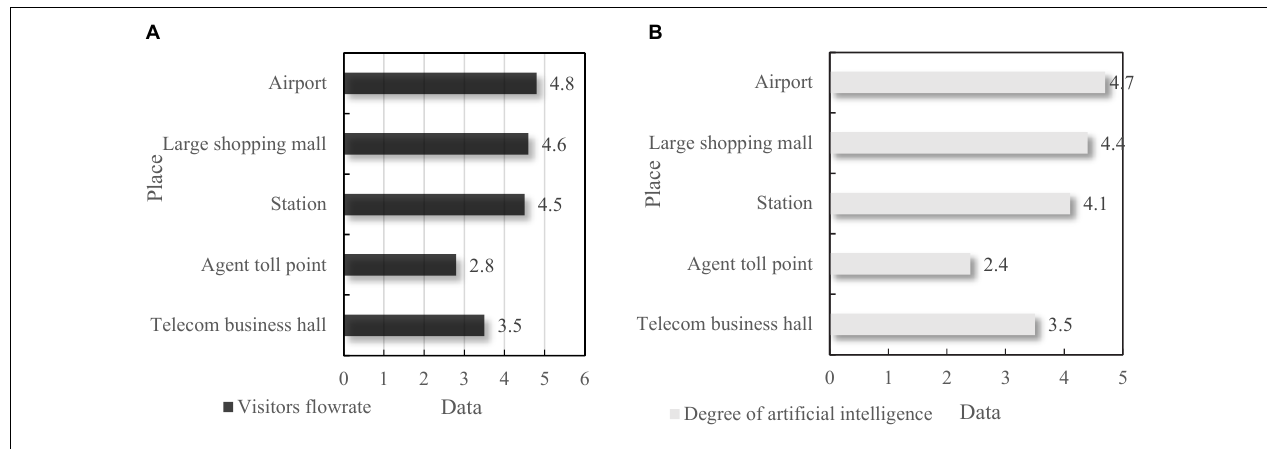
FIGURE 8 | Integrated performance analysis of financial self-service terminals. (A) Time. (B) Occupancy rate.